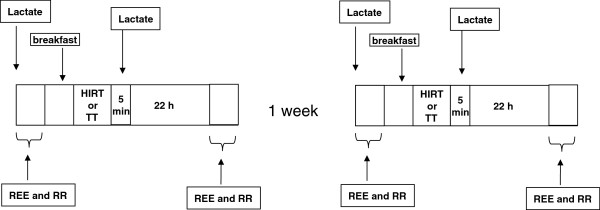
Scheme of experimental design.